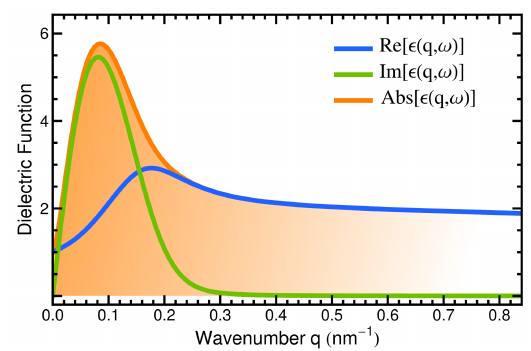
Figure 5: Dielectric function. Momentum dependence of the real and imaginary part as well as the absolute value of the dielectric function ϵ c ( q , ω 01 ) for the energy transfer (cid:126) ω 01 = ϵ +1 − ϵ 0 , and the parameters B = 4T , µ = 0 , T = 300K , and δ = 7meV . The figure is taken from Ref. [73]. Copyright (2014) by Nature Publishing